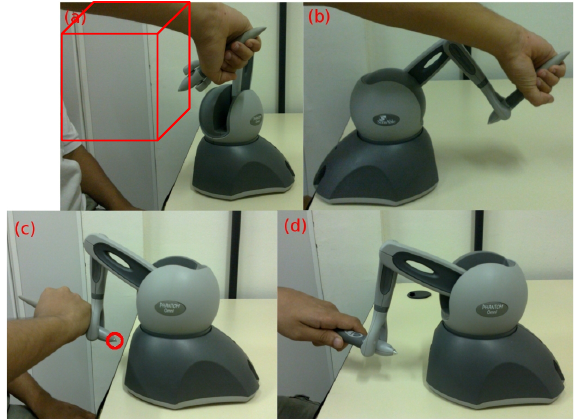
Fig. 3. Observations about the manipulation of the device when handling it as a toothbrush: a) limitation of workspace; b) device in reverse position; c) inversion of handling; d) handling for a third person approach.